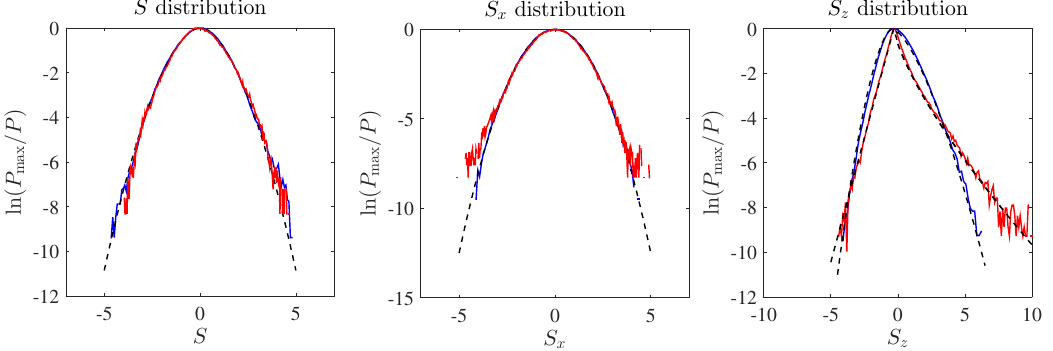
Figure 12. Pdfs of S , S x and S z for Ra = 1.02 (blue) and 1.7 (red). Parameters of the dashed stretched Gaussian curves shown alongside are given in Table